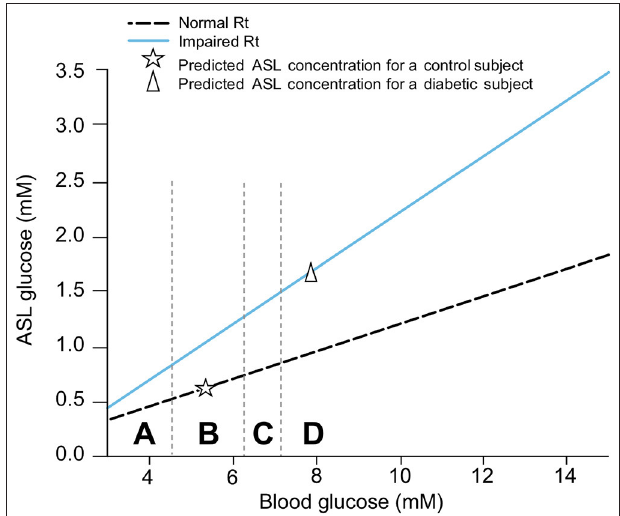
FIGURE 17 | Simplified model of the combined effect of blood glucose concentration and tight junction permeability (normal or impaired Rt) on ASL glucose concentration. The model predicts the trajectory of glucose concentration in the ASL in function of the concentration of glucose in the blood, in case of normal (dashed line), or impaired (blue line) epithelial resistance (Rt) (see section Methods). The star shows the predicted value of ASL glucose concentration for a control subject (normal blood glucose and epithelial resistance in the lung). The triangle shows the predicted value of ASL glucose for a diabetic subject (hyperglycemia and impaired epithelial resistance in the lung due to chronic inflammation). These predictions correspond to reported values in literature for control or diabetic subjects, validating the model proposed. A = hypoglycemia, B = normal FPG, C = IFG, D = acute hyperglycemia or